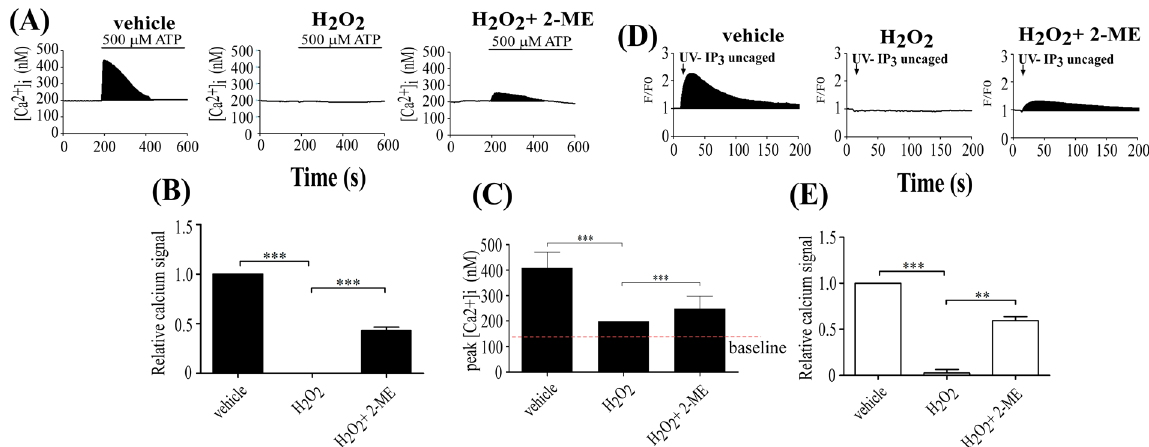
Figure 3. β -mercaptoethanol (2-ME) restored Ca 2 + response in KC in exposure to H 2 O 2 . ( A ) Ca 2 + signal in each group (pretreatment with vehicle, 500 μ M H 2 O 2 , and 500 μ M H 2 O 2 + 2-ME) was induced by addition of ATP (black bars). ( B , C ) Quantification of the black areas representing ATP-induced Ca 2 + signals ( B ) and the peak of the intracellular Ca 2 + responses ( C ) shown in ( A ) (N = 3). (D) Ca 2 + signal in each group (pretreatment with vehicle, 500 μ M H 2 O 2 , 500 μ M H 2 O 2 + 2-ME) was stimulated by photolysis-induced uncaging of caged-IP 3 . ( E ) Quantification of the black areas in ( D ) represent the amount of Ca 2 + released by the uncaged IP 3 ( * P < 0.05; ** P < 0.01; *** P <